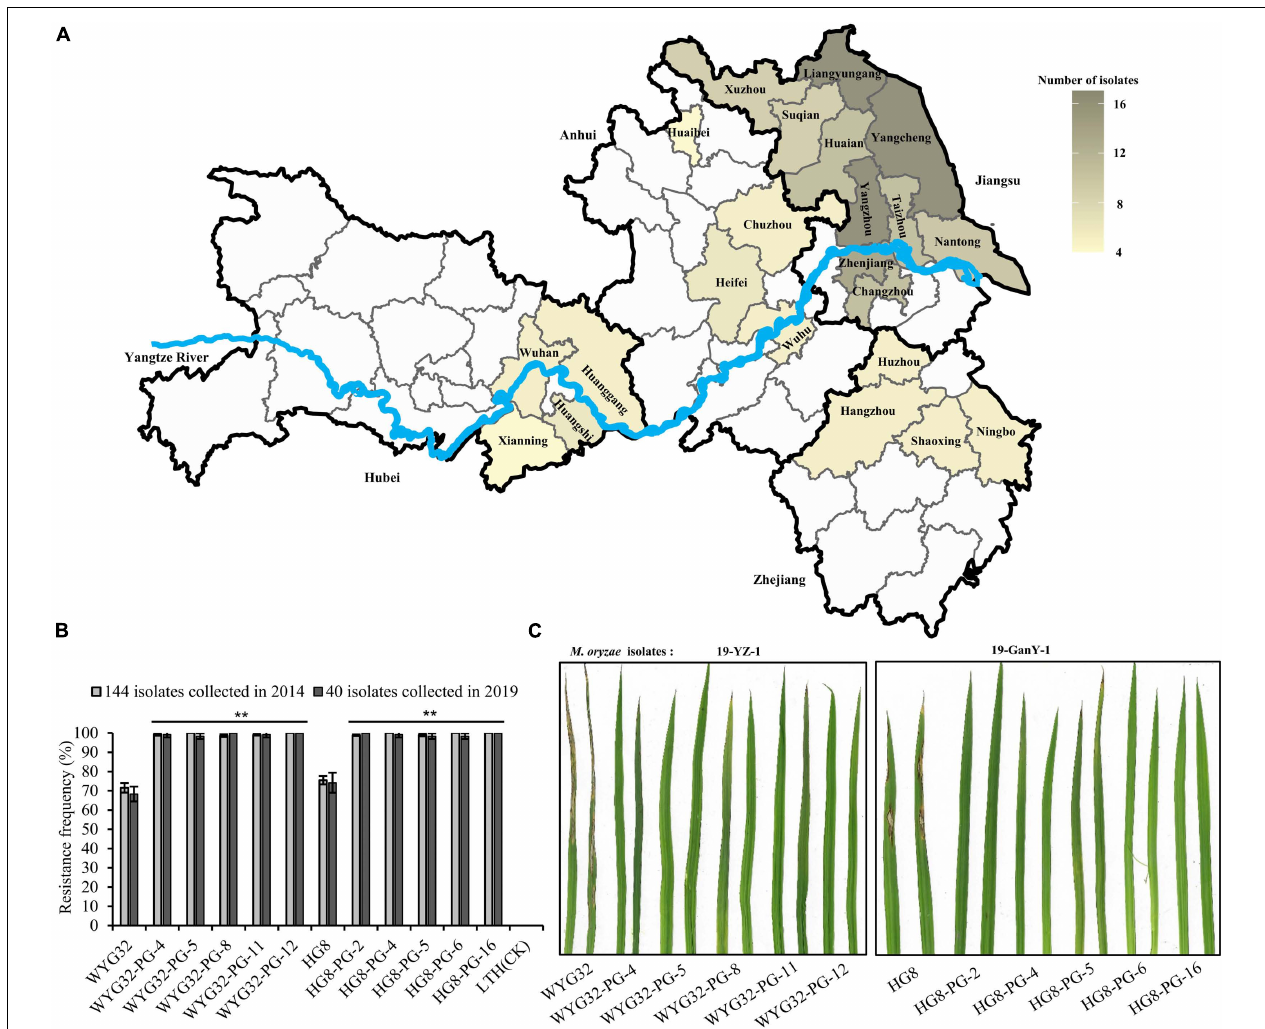
FIGURE 2 | Blast resistance scores of ABLs and the recurrent parents at the seedling stage. (A) Distribution of 184 M. oryzae isolates used for seedling blast inoculation in the lower region of the Yangtze River. (B) Comparison of resistance frequencies among ABLs and the recurrent parents (WYG32 and HG8) against M. oryzae isolates. (C) Seedling blast disease reactions of ABLs against two M. oryzae isolates, 19-YZ-1 and 19-GanY-1. ** P < 0.01 compared with the recurrent parent by Student’s t -test.